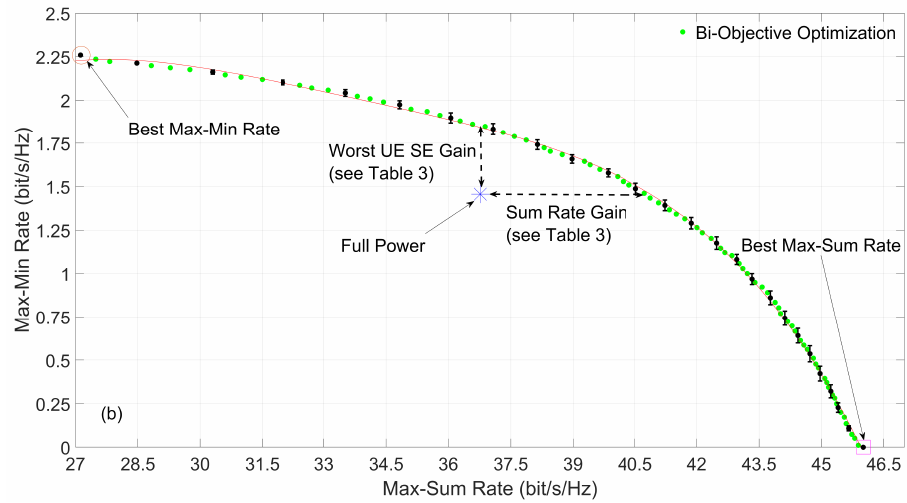
Figure 3. Bi-objective power optimization, max–min fairness and max–sum rate OF in a medium UE density RS network with ( a ) high and ( b ) low maximum power.